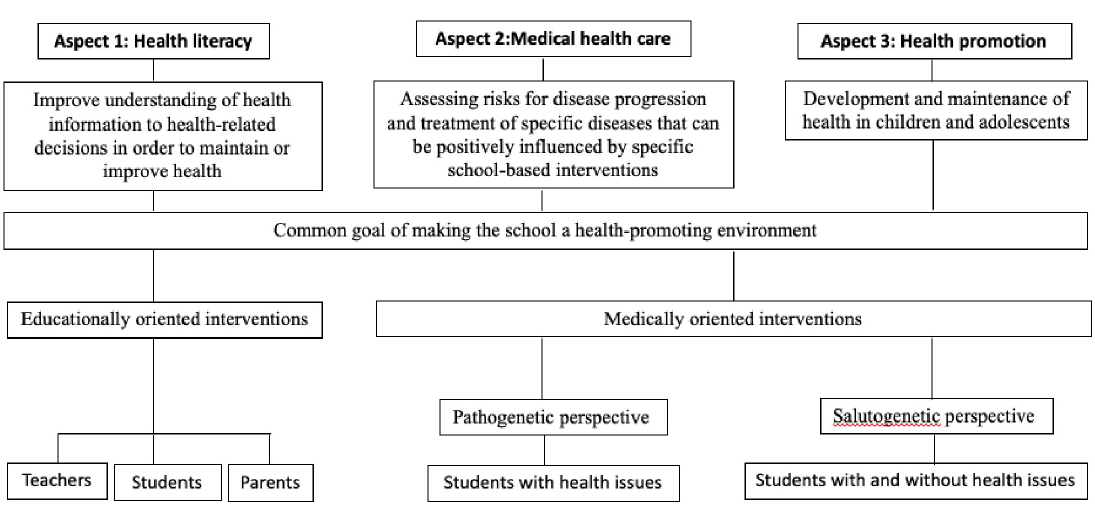
Fig 7. Classification of the school nurse’s working fields according to their approaches and perspectives. Notes. Three core aspects of school health 1) health literacy, 2) medical health care, and 3) health promotion complement each other in terms of the common goal of making the school a health-promoting environment but differ in their approaches and strategies to achieve this